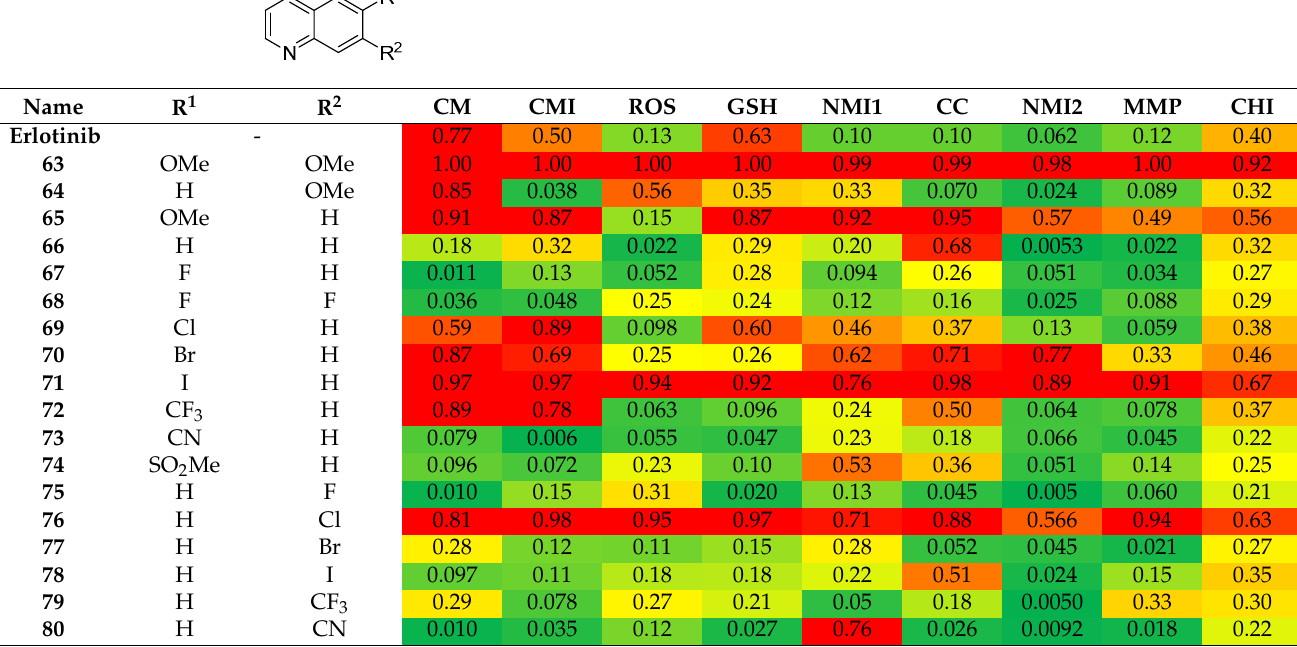
a Abbreviations from columns left to right. CM: Cell morphology; CMI: Cell membrane integrity; ROS: Reactive oxygen species; GSH: Glutathione; NMI1: Nuclear membrane integrity 1; CC: Cell Cycle; NMI2: Nuclear membrane integrity 2; MMP: Mitochondrial membrane potential; CHI: Cell Health Index. b Traffic light colouring matching classifier values (Red–Green: high toxicity risk–low toxicity risk). c all n =